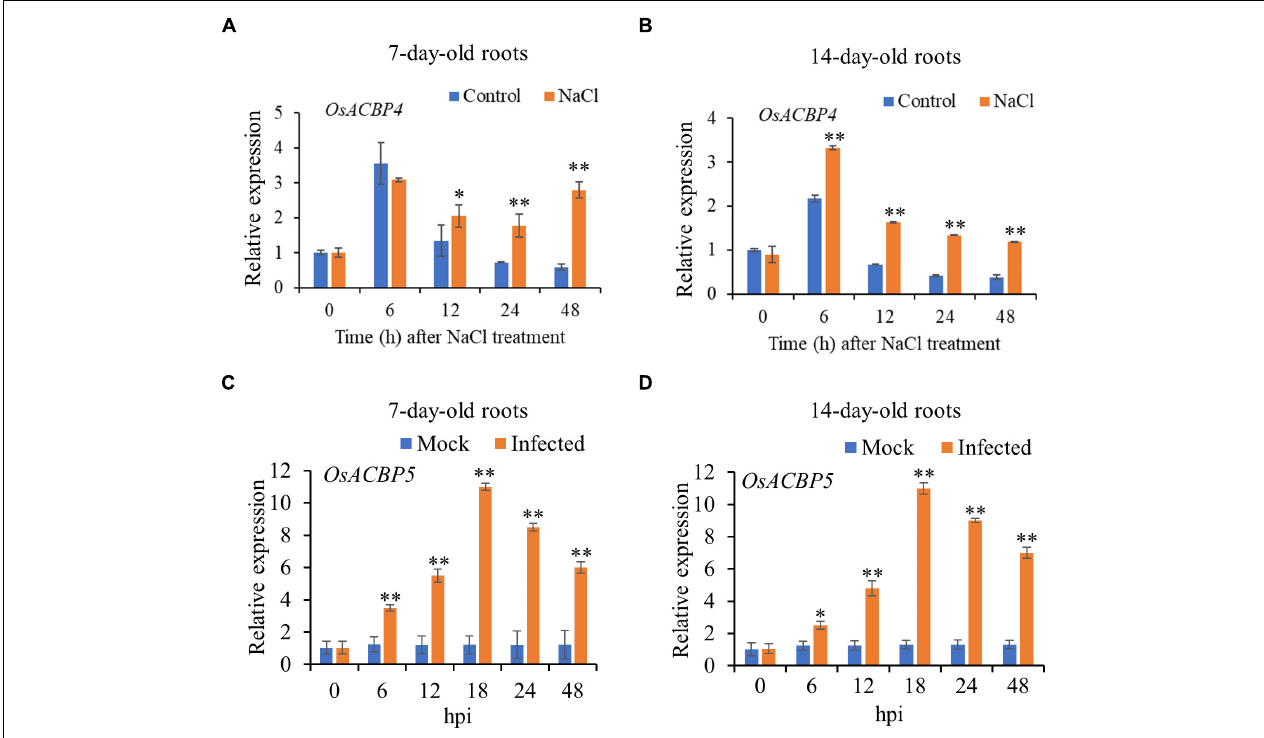
FIGURE 1 | Expression of OsACBP4 and OsACBP5 after stress treatment in wild-type (WT) rice roots. (A) OsACBP4 expression in 7-day-old NaCl-treated roots; (B) OsACBP4 expression in 14-day-old NaCl-treated roots; (C) OsACBP5 expression in 7-day-old Rhizoctonia solani -treated roots; (D) OsACBP5 expression in 14-day-old R. solani -treated roots. Total RNA was extracted from 7- and 14-day-old rice after NaCl treatment or after R. solani treatment at 0, 6, 12, 18, 24, and 48 h. Data are means ± SD of three independent replicates. Asterisks indicate a significant difference between the treatments and controls (* P < 0.05; ** P < 0.01 by Student’s t -test). hpi, hours post